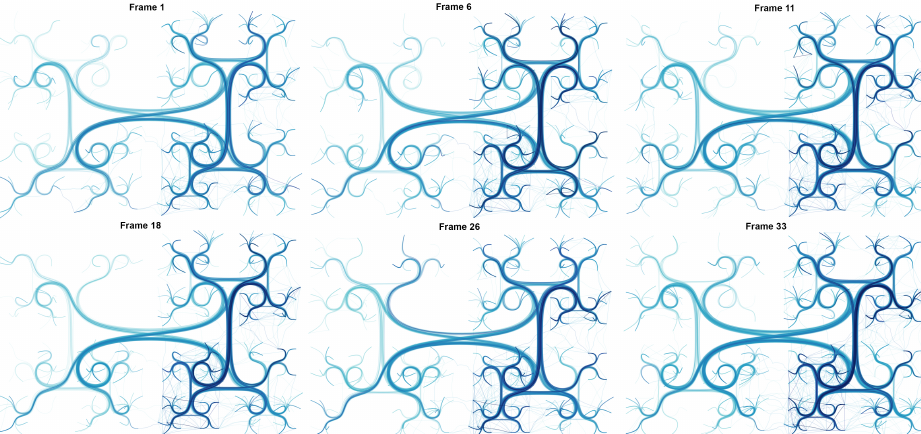
Figure 15. Small-multiples visualization for multiple voting frames of the #NBABallot dataset. The same dominant patterns of Figure 14 are visible but their density change over time, a pattern potentially related to game days or marketing campaigns asking for votes.